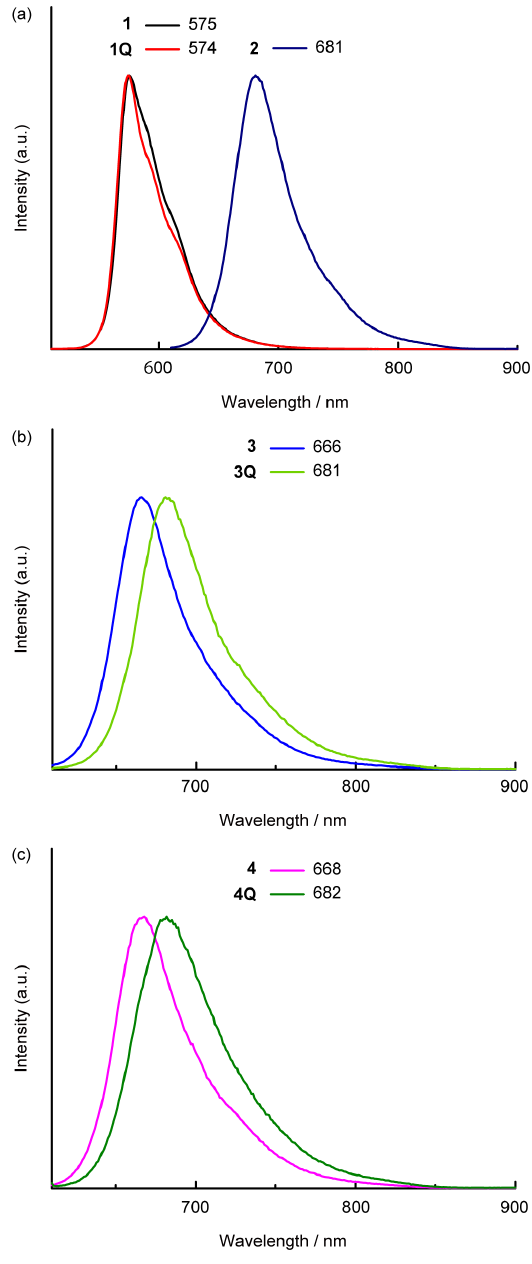
Figure 4. Fluorescence spectra of SubPcs in dichloromethane solutions. ( a ) 1 (black), 1Q (red), and 2 (purple); ( b ) 3 (blue), and 3Q (light green); ( c ) 4 (pink) and 4Q (green). λ ex = 500 nm (for 1 and 1Q ) and 600 nm (for 2 , 3 , 3Q , 4 and 4Q ).